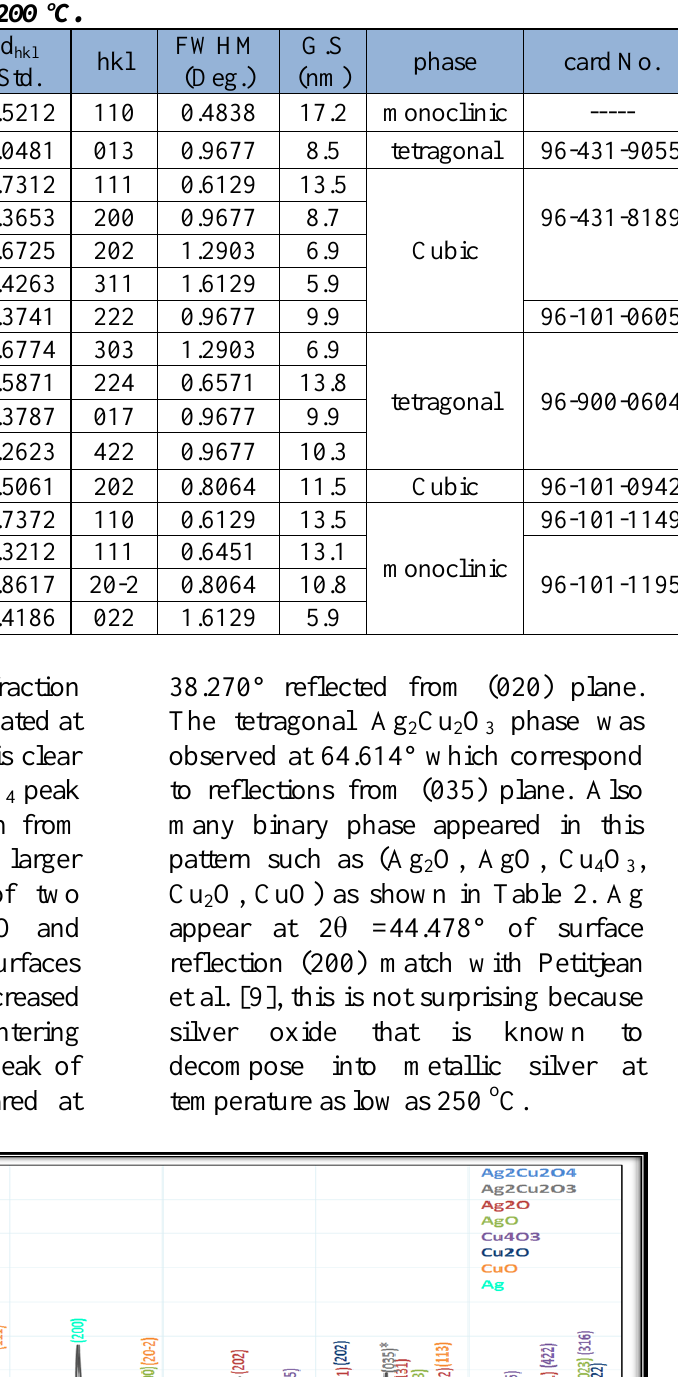
Cu O powder at sintered at 2 2 4